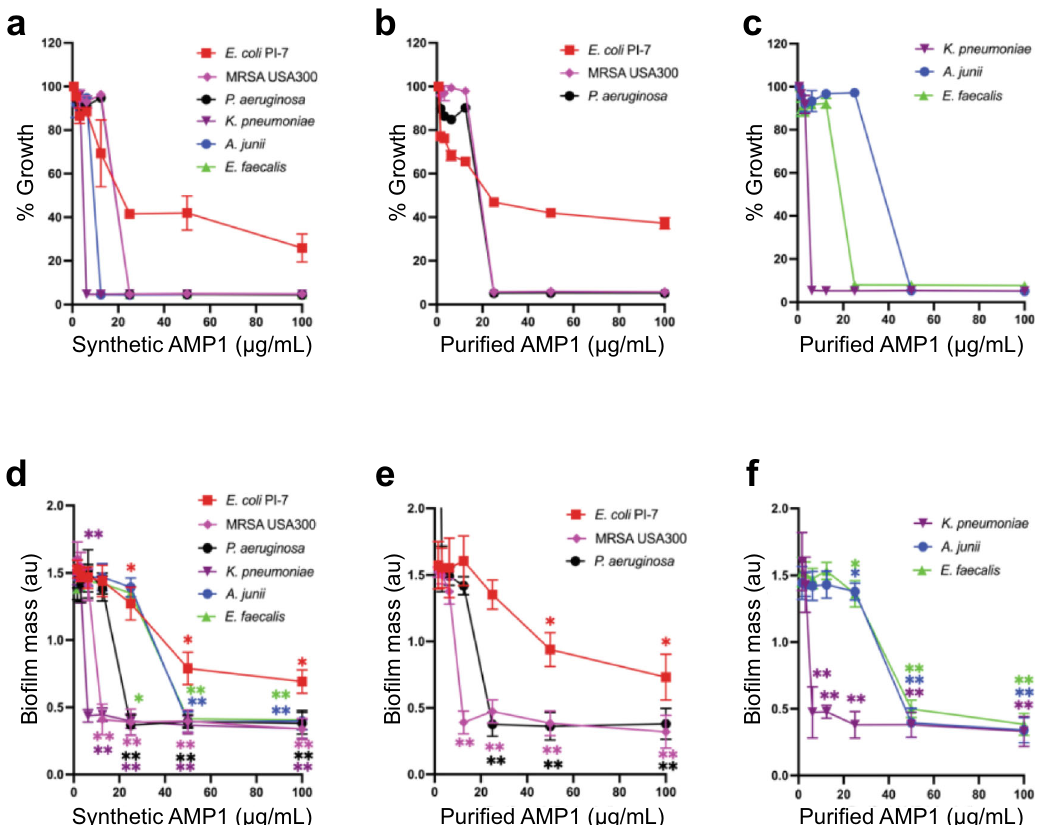
Fig.4|Experimentalvalidationofantimicrobialactivityofplant-puri fi edAMP1 against ESKAPE pathogens and their prevention of bio fi lm formation. syntheticand puri fi ed peptideforthepreventionof bio fi lm